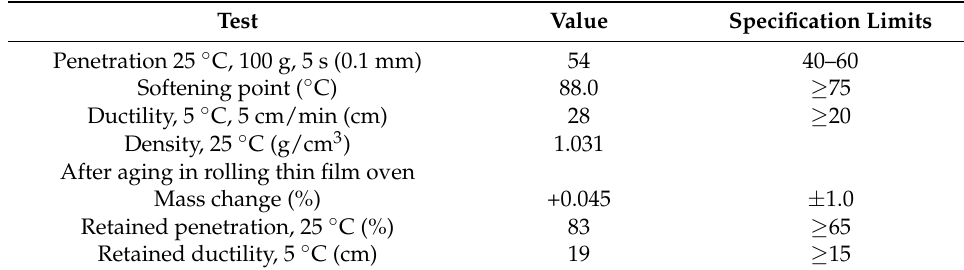
Table 1. Properties of SBS modified asphalt.